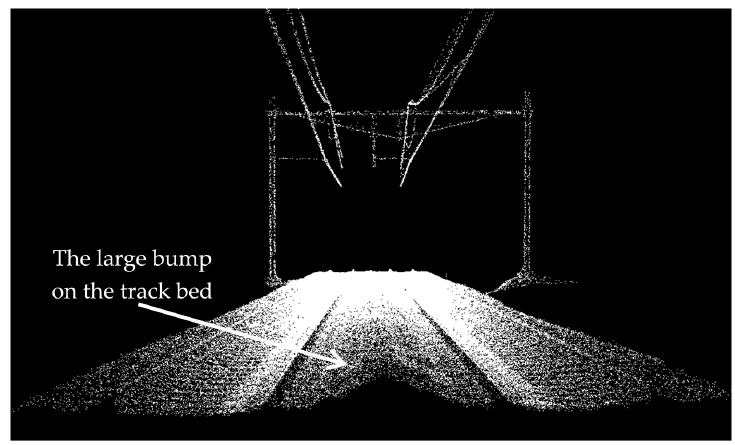
Figure 13. The presence of a large bump on the track bed induces some false positives in the results